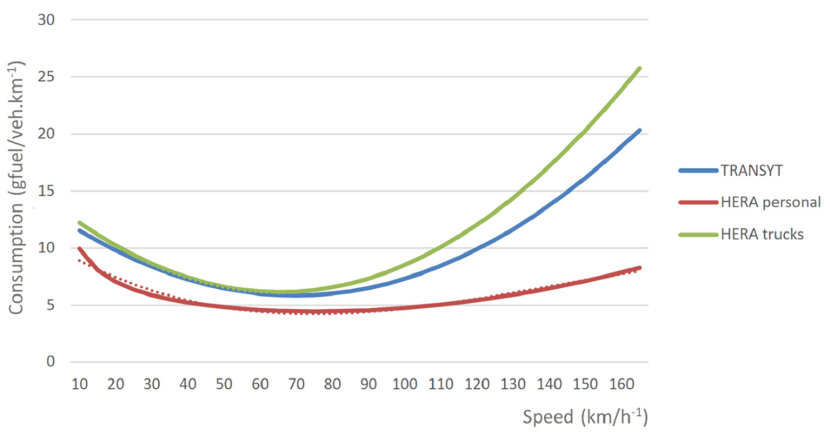
Figure 4. Comparison of fuel consumption (in liters per 100 km) according to models HERA COPERT and TRANSYT.